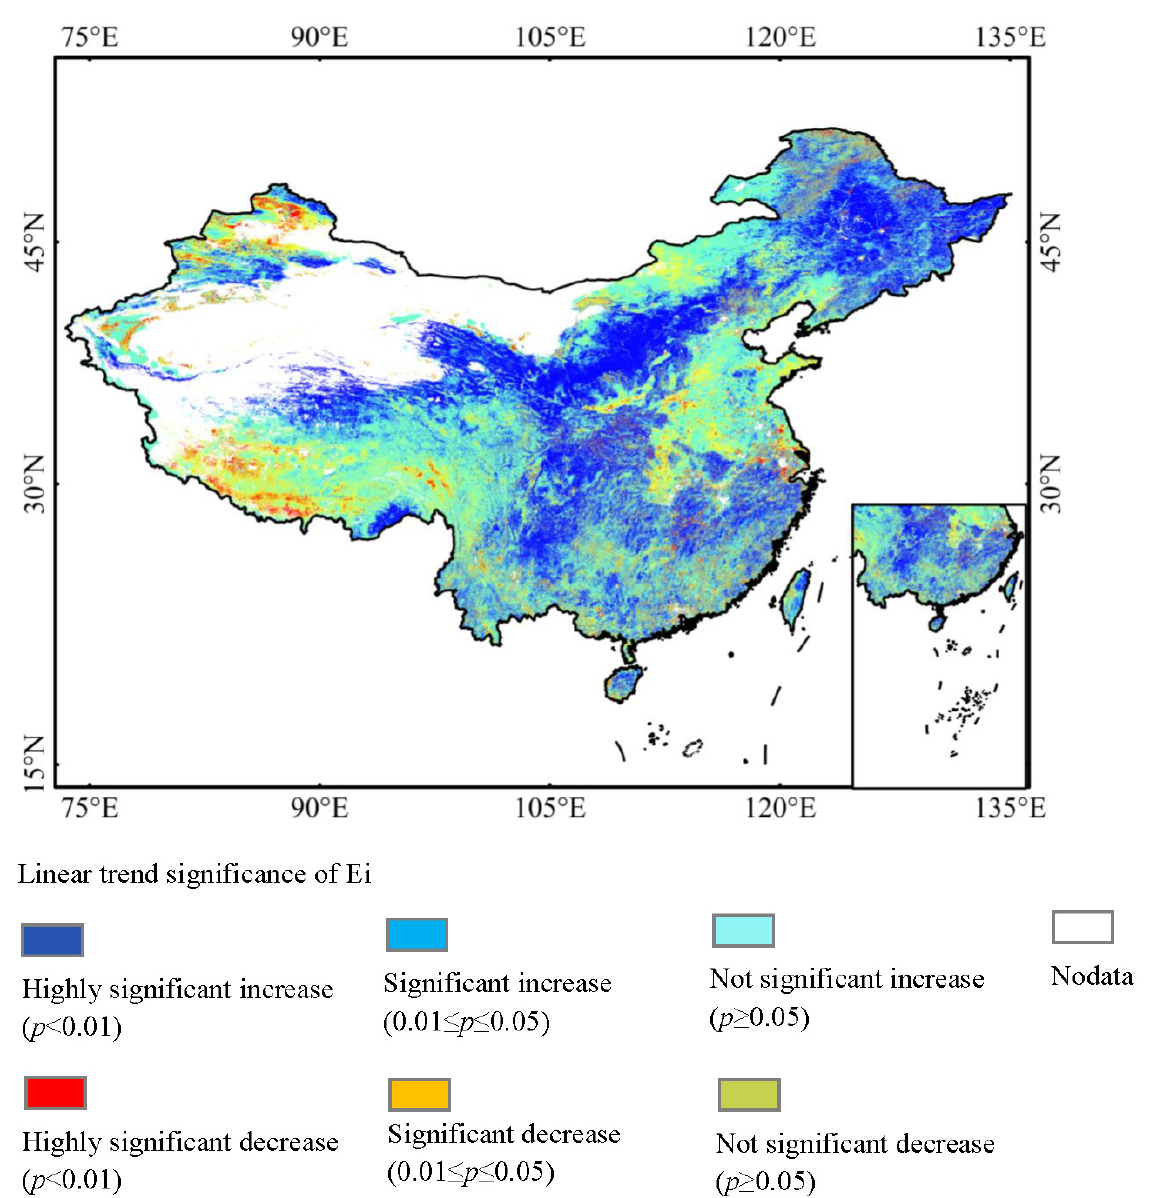
Figure 6. The spatial distribution of significance for the interannual change of Ei across China during 2001 − 2020.